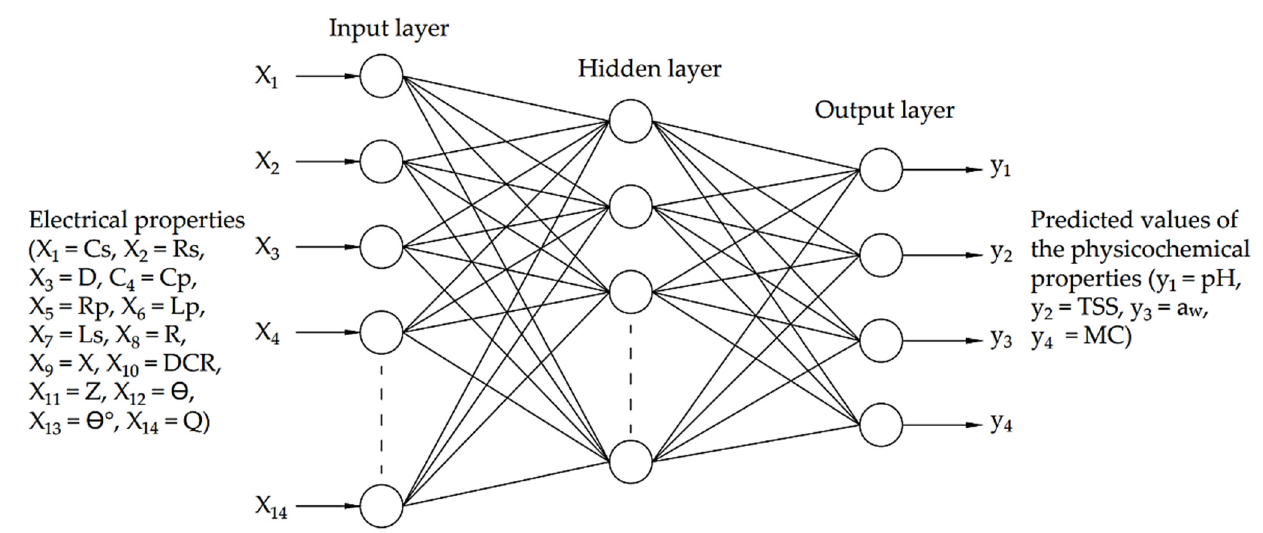
Figure 3. Artificial neural network architecture.